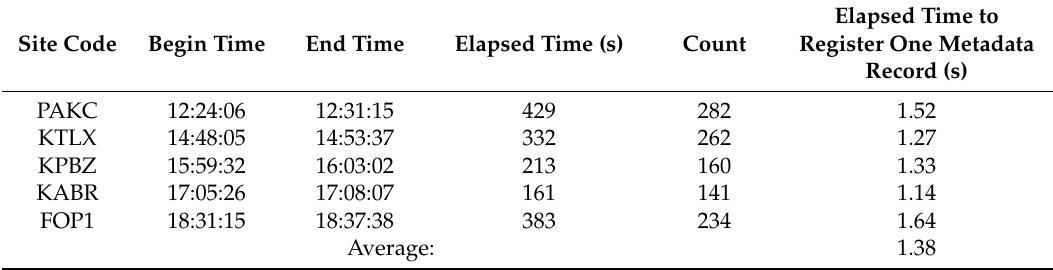
Table 3. Elapsed time to registering NEXRAD III radar metadata for five sites.